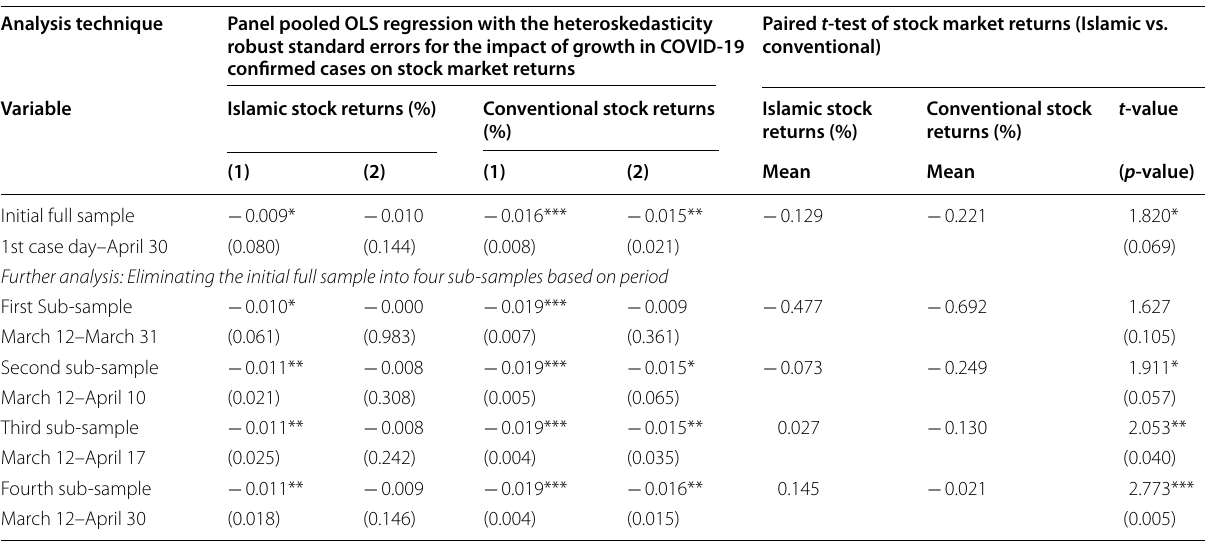
Table 6 Summary of regression and paired t -test analysis for the Islamic and conventional stock market returns during COVID-19